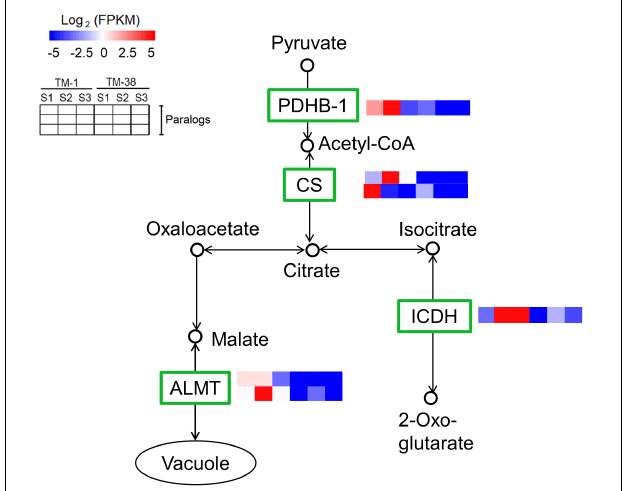
FIGURE 7 | Differential expression of genes involved in citrate cycle (TCA cycle) pathway in TM-1 and TM-38 at three developmental stages. Heat maps depict the normalized gene expression values, which represent the means ± SD of three biological replicates. Expression values of 18 libraries are presented as FPKM normalized log 2 -transformed